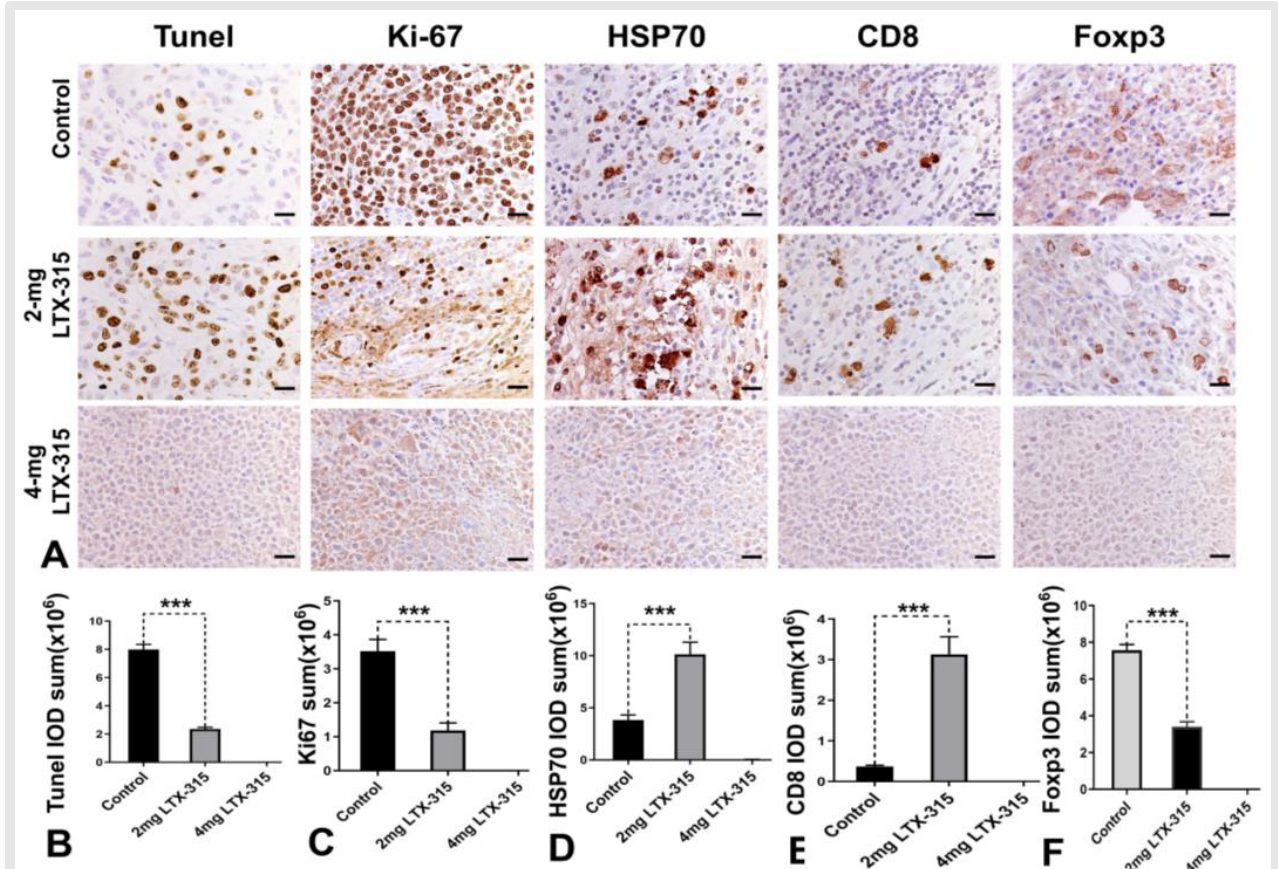
Figure 6. The immunohistochemical analysis of tumors among three treatment groups. ( A ) Due to the complete necrosis of tumor, there were no apoptotic cells, proliferative cells, HSP 70, CD8 + T cells, and Tregs in the ablated tumor areas in the 4 mg LTX-315 therapy group. ( A – C ) There were more apoptotic cells (yellow brown dots) and fewer proliferating cells (yellow brown dots) in the 2 mg LTX-315 therapy group than the control group. ( A , D – F ) The staining of HSP70, CD8, and Foxp3 demonstrated there were more HSP70 and CD8 + T cells and fewer Tregs in the residual tumors in the 2 mg LTX-315 therapy group than the control group. (Scale bars, 20 µm) (*** p < 0.001).